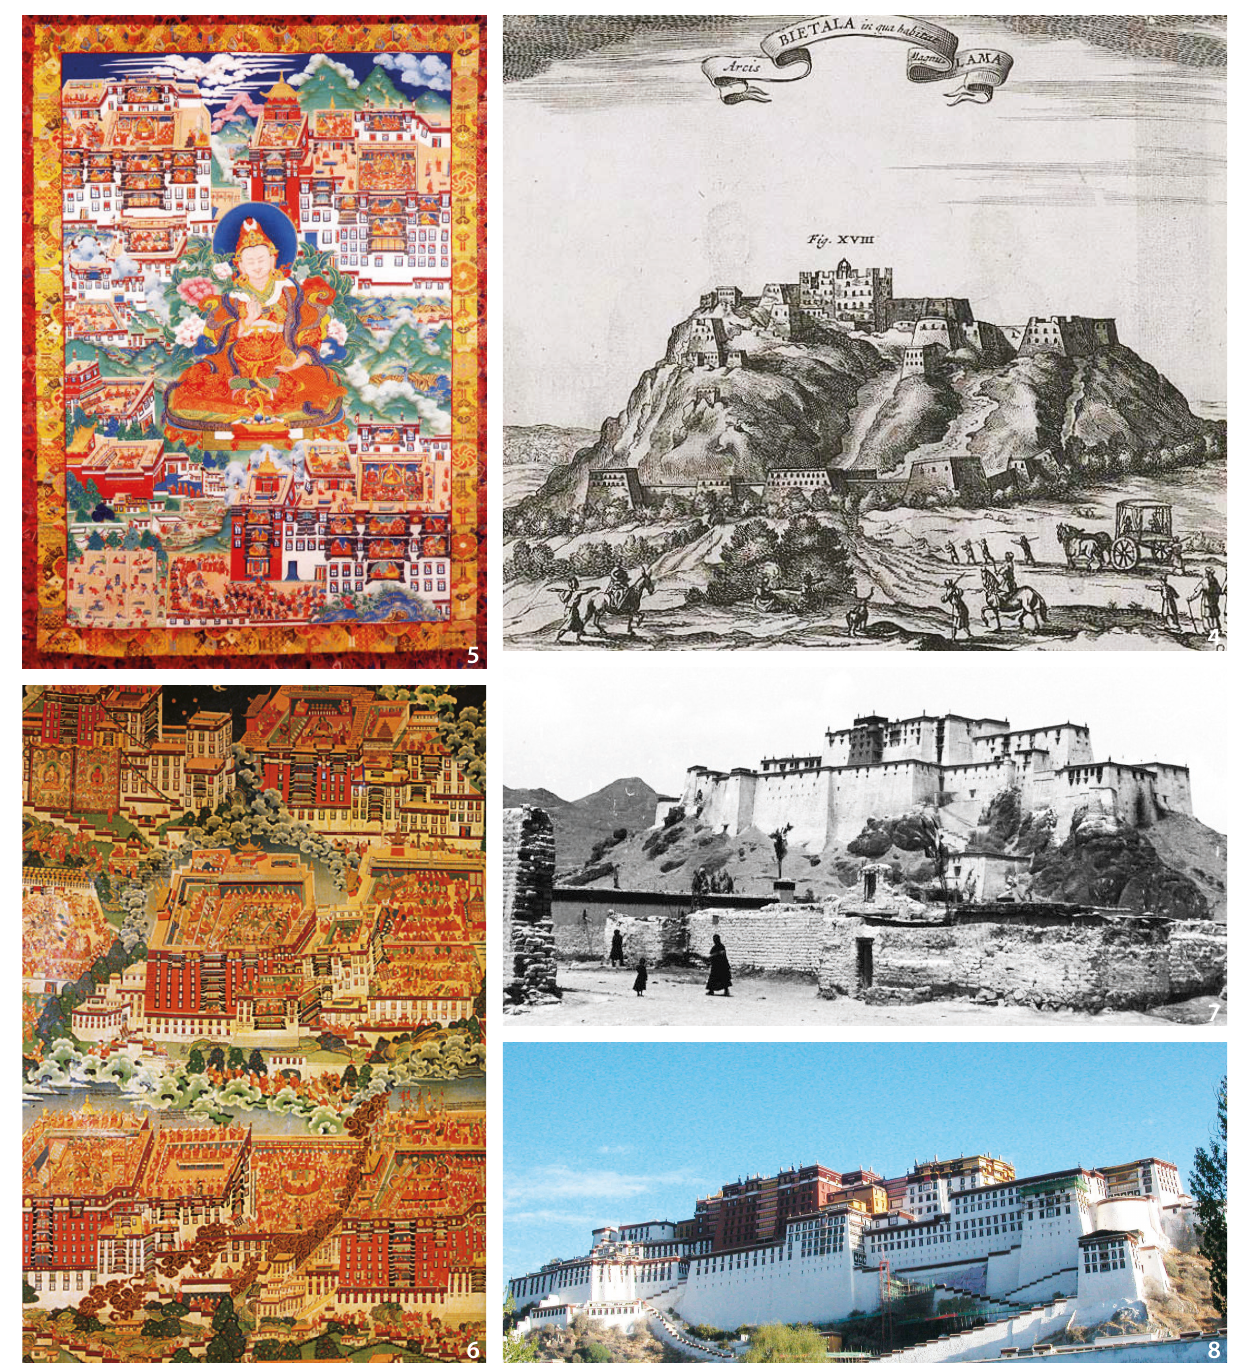
Figure 4 Illustration of Polata Palace in China Illuserata (Source: Kircher 2010). Figure 5 Potala Palace in the Thangka from 17 th century (Source: http://mt.sohu.com/20150213/n409001492.shtml). Figure 6 Wall painting in Potala Palace showing the scene of the completion of its Red Palace (Source: http://mt.sohu.com/20150213/n409001492. shtml). Figure 7 Picture of Sangzhutse Fortress taken by Ernst Schäfer during the 1930s (Source: